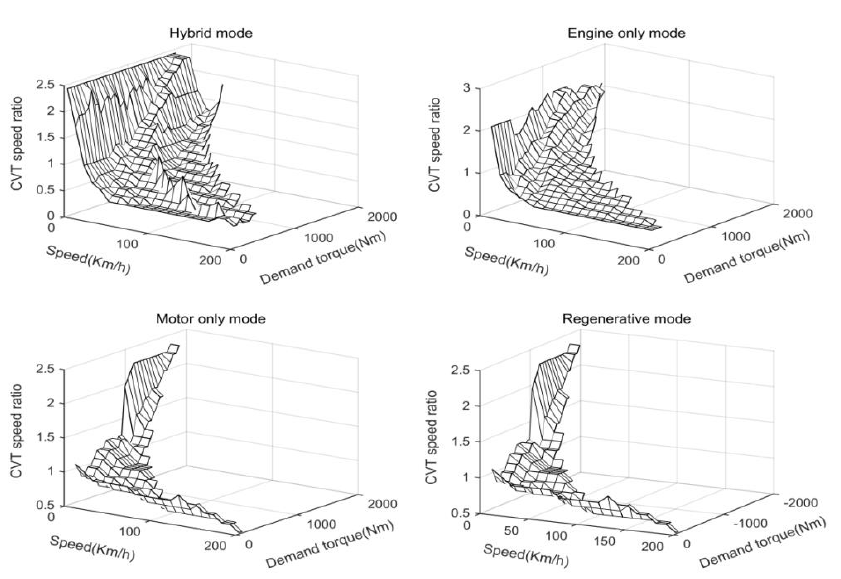
Figure 2. CVT optimal speed ratio in each mode.